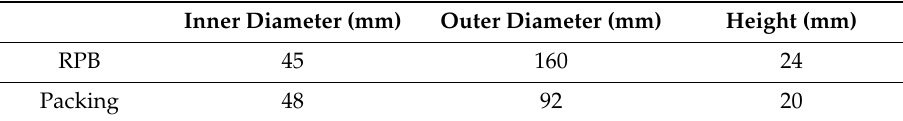
Table 1. The main geometric dimensions of RPB.